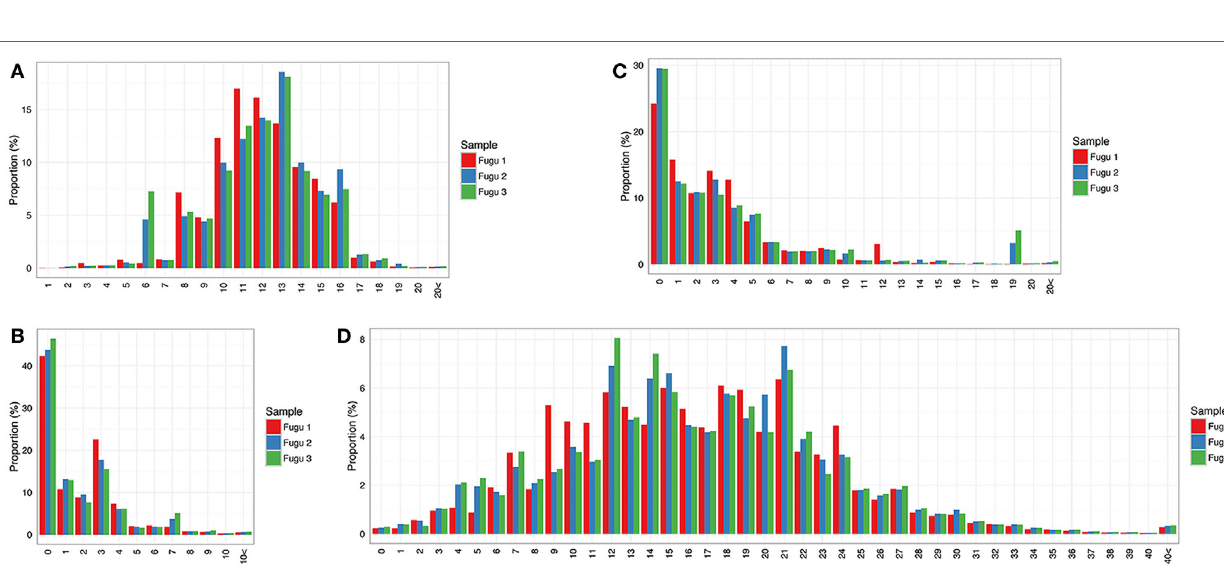
FigUre 4 | Sequence diversity of heavy (H) chain complementarity-determining region 3 (CDR-H3) repertoire in IgM. (a) Distribution of CDR-H3 amino-acid length. (b,c) Distribution of the total number of nucleotide deletions and (D) V–J insertion.